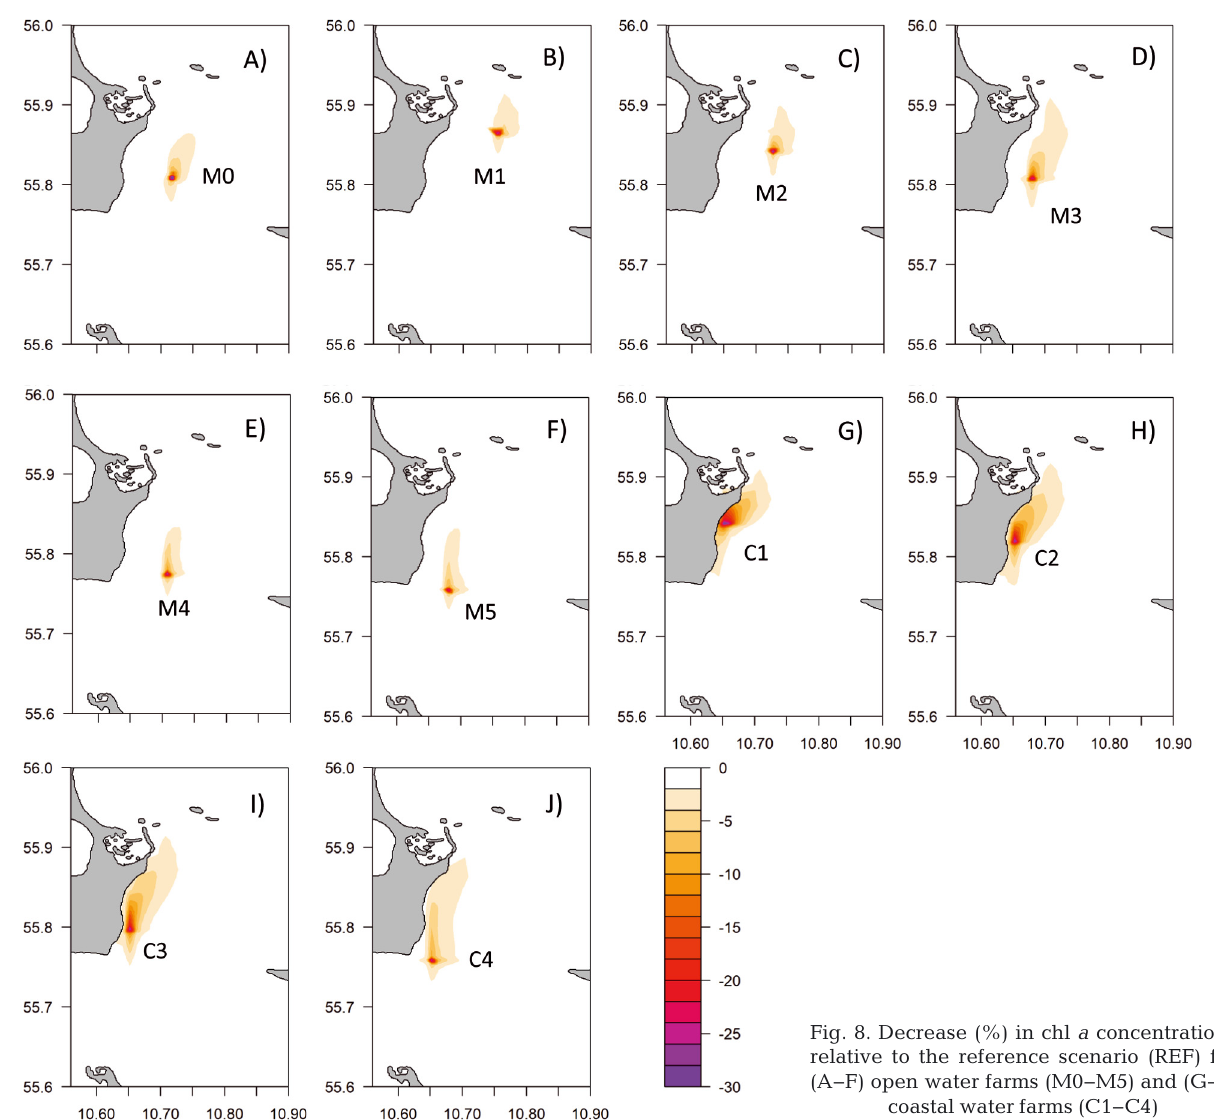
Fig. 8. Decrease (%) in chl a concentrations relative to the reference scenario (REF)